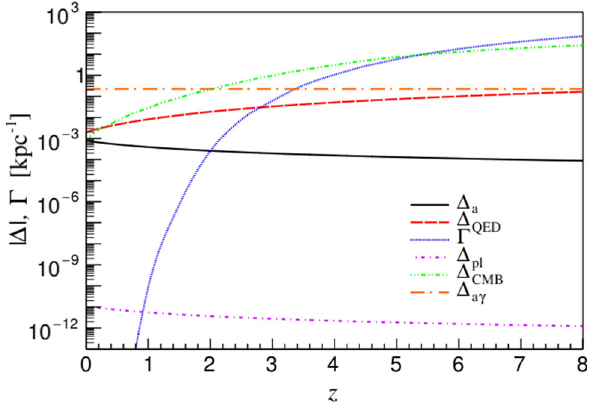
Fig. 7 Average (cid:15) P s γ → a (cid:16) conversion probabilities in the host galaxy at Fig. 6 Redshift evolution of the factors (cid:11) a (black continuous curve), E = 10 TeV as a function of the redshift z of the source. We take (cid:11) (cid:13) (blue dotted curve), (cid:11) QED (red dashed curve), pl (magenta dot- g a γ = 3 × 10 − 11 GeV − 1 and consider B T = 8 × 10 − 6 G (red curves) dashed curve), (cid:11) CMB (green dot-dashed curve) and (cid:11) a γ (orange long and B T = 5 × 10 − 6 G (black curves). The continuous curve are for dot-dashedcurve)evaluatedat E = 10TeV, B = 5 μ G, m a (cid:14) 10 − 7 eV a single box regular B -field, while the dashed curves refer to the cell and g a γ = 3 × 10 − 11 GeV − 1 model